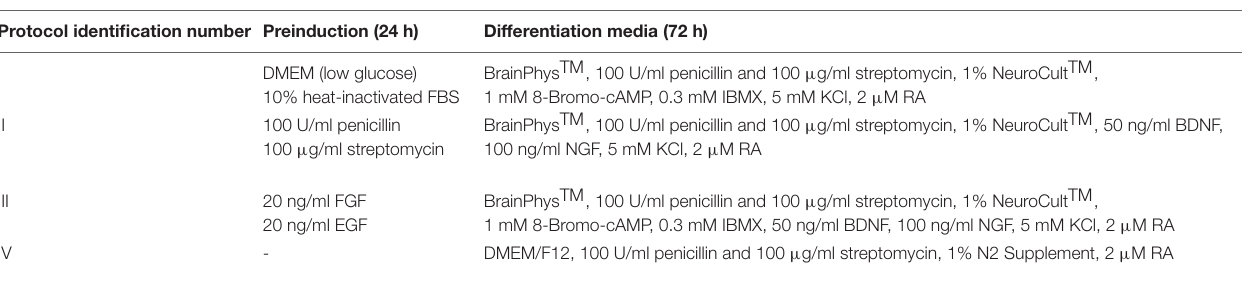
TABLE 1 | Neurogenic differentiation conditions. Protocol identification number Preinduction (24